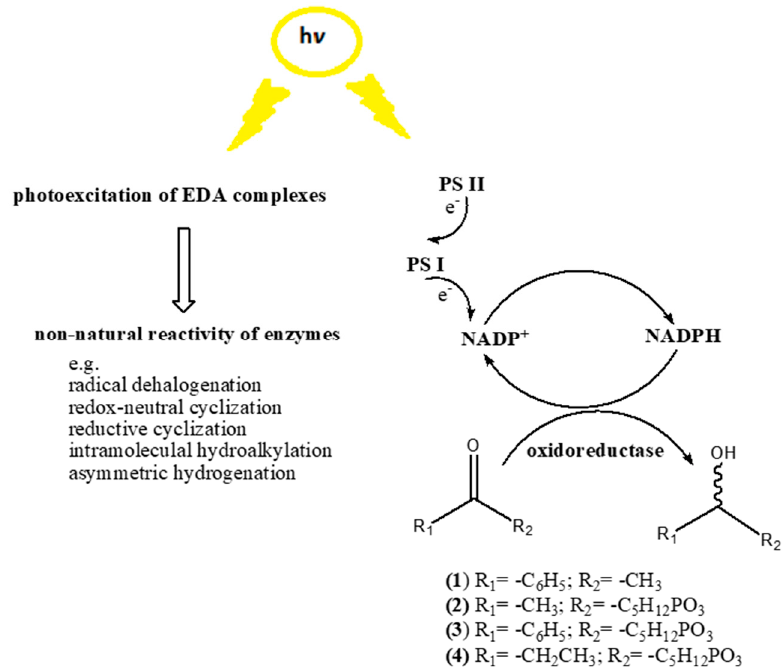
Scheme 2. Possible effects of light on enzyme activity in phototrophic